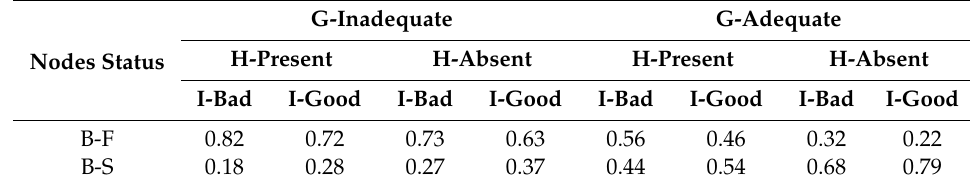
Figure 4. The learned BN-CPEA model. Table 1. Conditional probability tables for the “operation error” node.